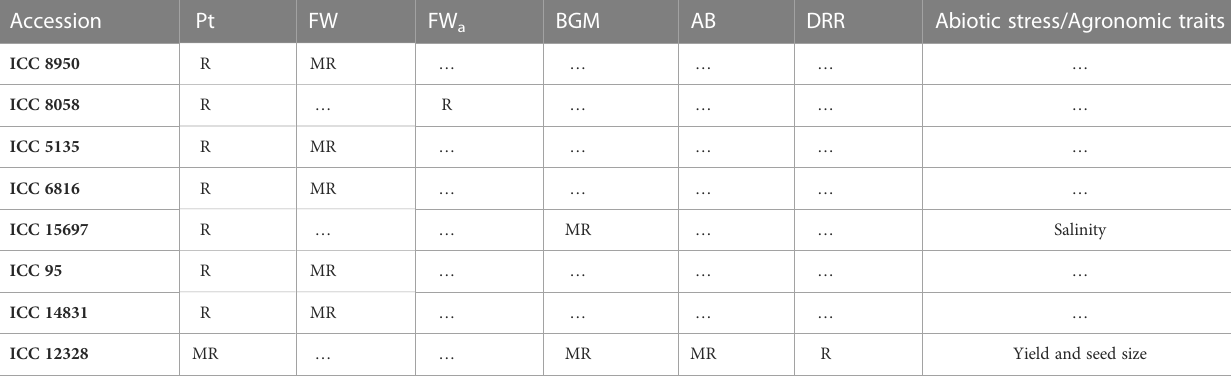
TABLE 1 The chickpea accessions in resistant (R) and moderately resistant (MR) categories to Pratylenchus thornei of present study collated with reports of multiple disease resistance or tolerance to abiotic stress and/or with superior agronomic traits from the